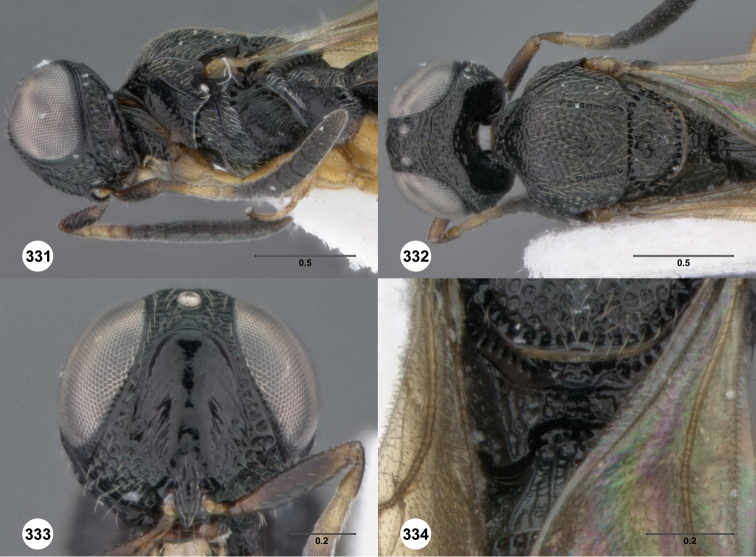
Oxyscelio sinuationis sp. n., holotype female (OSUC 368209) 331 Head and mesosoma, lateral view 332 Head and mesosoma, dorsal view 333 Head, anterior view 334 Propodeum, posterodorsal view. Morphbank90